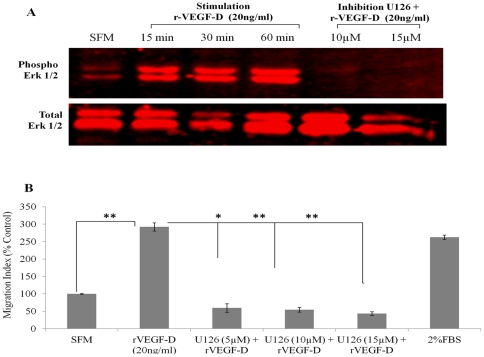
VEGF-D induced migration of HMVEC-dLy cells is Erk dependent:(A) Cells were serum starved for 24 h before stimulation with r-VEGF-D (20 ng/ml) for varying lengths of time (0, 15, 30 and 60 minutes) or pre-treated with varying concentrations of Erk inhibitor U0126 (0, 5, 10 and 15 µM) for one hour and further treated with 20 ng/ml r-VEGF-D for 30 minutes. Cell lysates were prepared and analyzed by western blot for Erk1/2 activity. VEGF-D stimulated Erk activation in HMVEC-dLy cells and this stimulation was prevented by pre-treatment with U126. (B) Cell migration was quantified by transwell migration assays; VEGF-D stimulated migration was inhibited with U126 (5–15 µM). 2% FBS served as a positive control. Migration data were represented as a mean ± S.E. for three independent experiments (n = 3). For recombinant VEGF-D stimulation, data were normalised to SFM and for Erk inhibition data were normalised to r-VEGF-D stimulation.